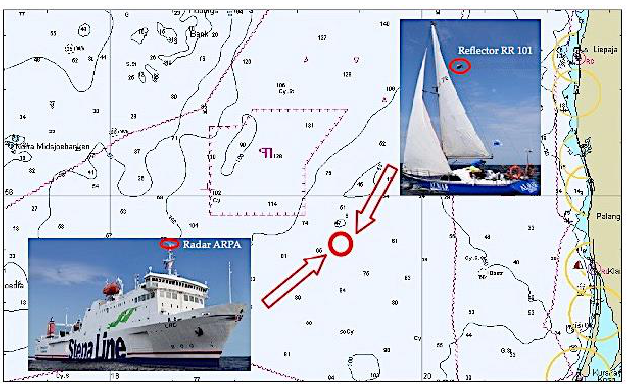
Figure 12. A situational sketch of the meeting between the m/f URD ferry and the s/y ALMAK yacht near the Latvian port of Liepaja (the meeting place of the ships is marked with a circle with arrows).